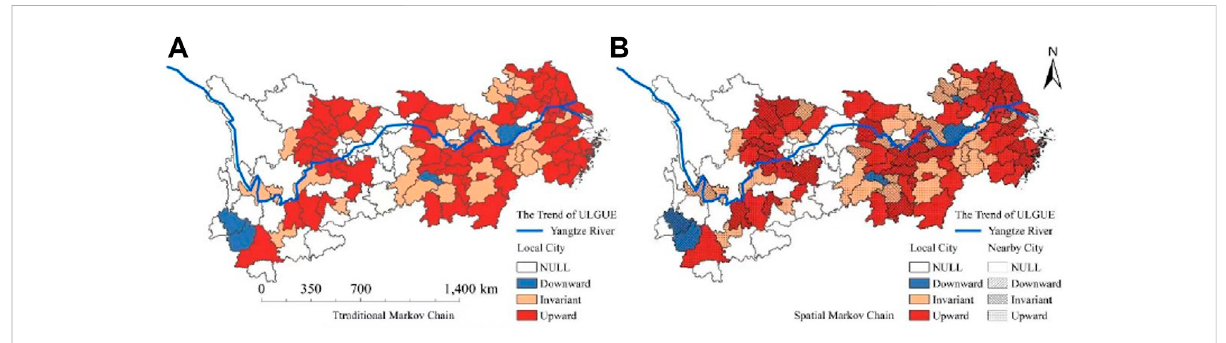
FIGURE 6 Spatial pattern of ULGUE transfer type in the Yangtze River Economic